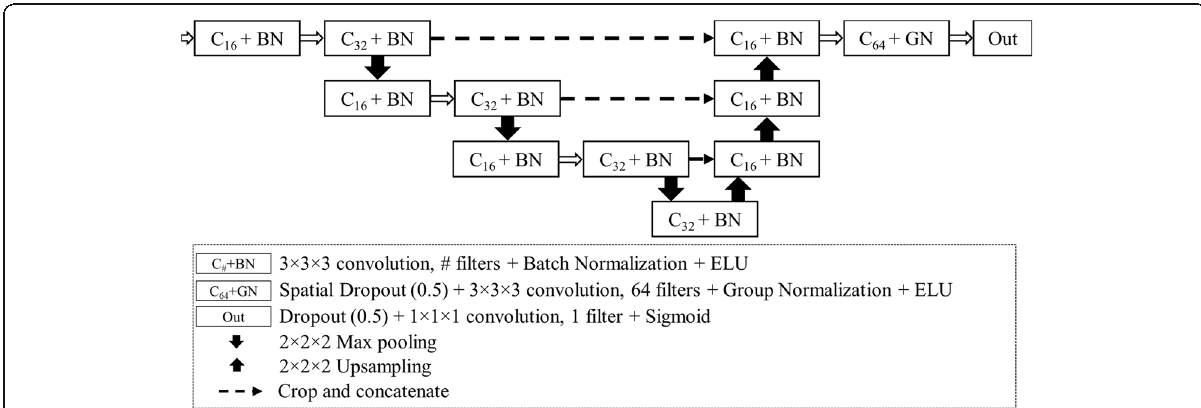
Fig. 1 The convolutional neural network architecture was based on U-net with three max-pooling steps in the downsampling pathway and linear upsampling in the resolution recovery path. Convolutional layers (C) were followed by batch or group normalisation and exponential linear unit (ELU) activations. Skip connections with cropping were used between the matching resolution levels (dashed arrows). C Convolutional layer, BN Batch normalisation, ELU Exponential linear unit, GN Group